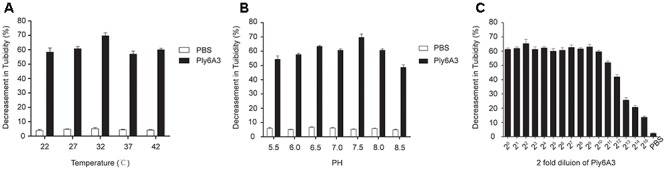
(A) The thermal stability of endolysin Ply6A3. Endolysin was incubated at various temperatures for 30 min. (B) The pH stability of endolysin Ply6A3. Endolysin was incubated at the indicated pH conditions for 30 min. (C) Activity unit of endolysin Ply6A3. The initial concentration was 3.9 mg/mL, then double dilution. Data were obtained from three independent experiments and are shown as mean ± SD. Ply6A3, the endolysin encoded by a novel Acinetobacter baumannii Phage PD6A3 gene. pH, hydrogen ion concentration. AB32, the No. 32 strains of Multidrug Resistance Acinetobacter baumannii.